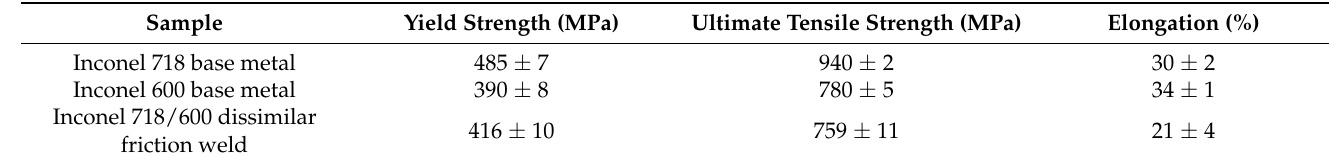
Figure 5. Typical engineering stress-strain curves of the Inconel 718 and Inconel 600 base metals and dissimilar friction welded joints. Table 3. Results of room temperature tensile testing (average properties from three tests in each case).